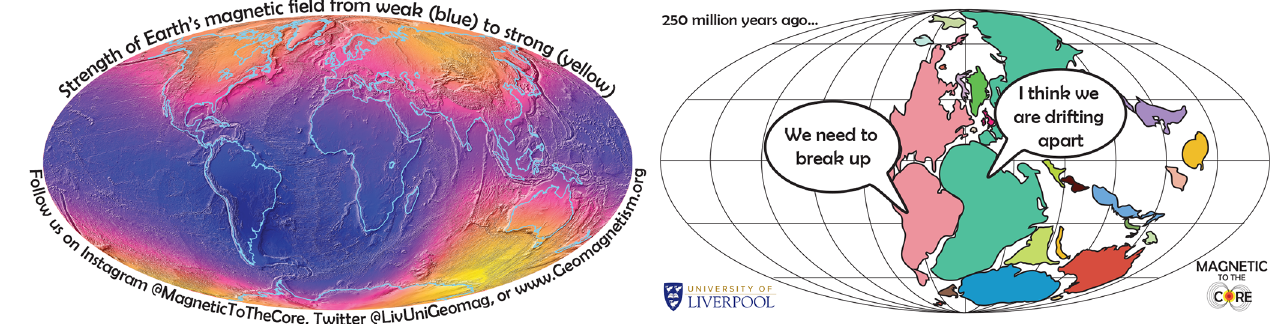
Figure 5. The sticker (left), with links to websites (http://www.geomagnetism.org/) and social media, and a fridge magnet (right) that were handed out to visitors of the